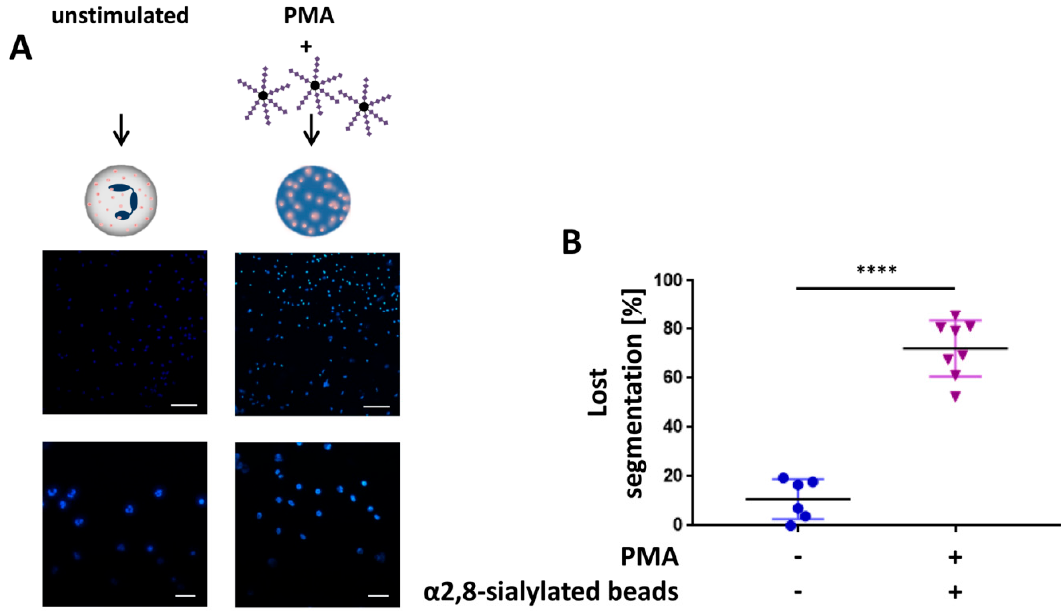
Figure 2. α 2,8-sialylated nanoparticles do not prevent the loss of nucleus segmentation. ( A ) DNA was stained with DAPI (blue) in unstimulated neutrophils in addition to neutrophils, which were stimulated with PMA (20 nM PMA for 4 h) in the presence of α 2,8-sialylated particles. Upper scale bar: 100 µ m, lower scale bar: 20 µ m. ( B ) Based on the fluorescence pictures, the total number of cells that lost their segmented structure was determined. Mean values ( n ≥ 6) and standard deviations are displayed. The statistical significance was calculated with the t -test with Welch’s correction. The statistically significant di ff erence is given as follows: **** p ≤ 0.0001.